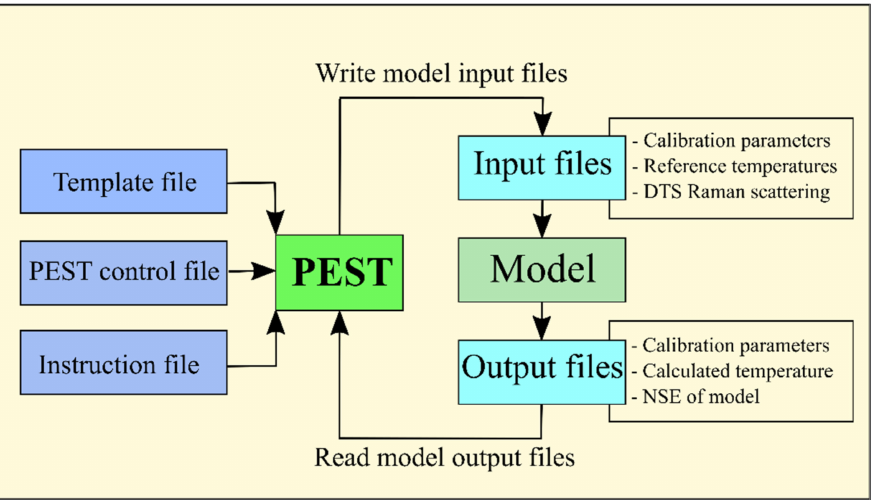
Figure 4. Schematic methodology of the PEST